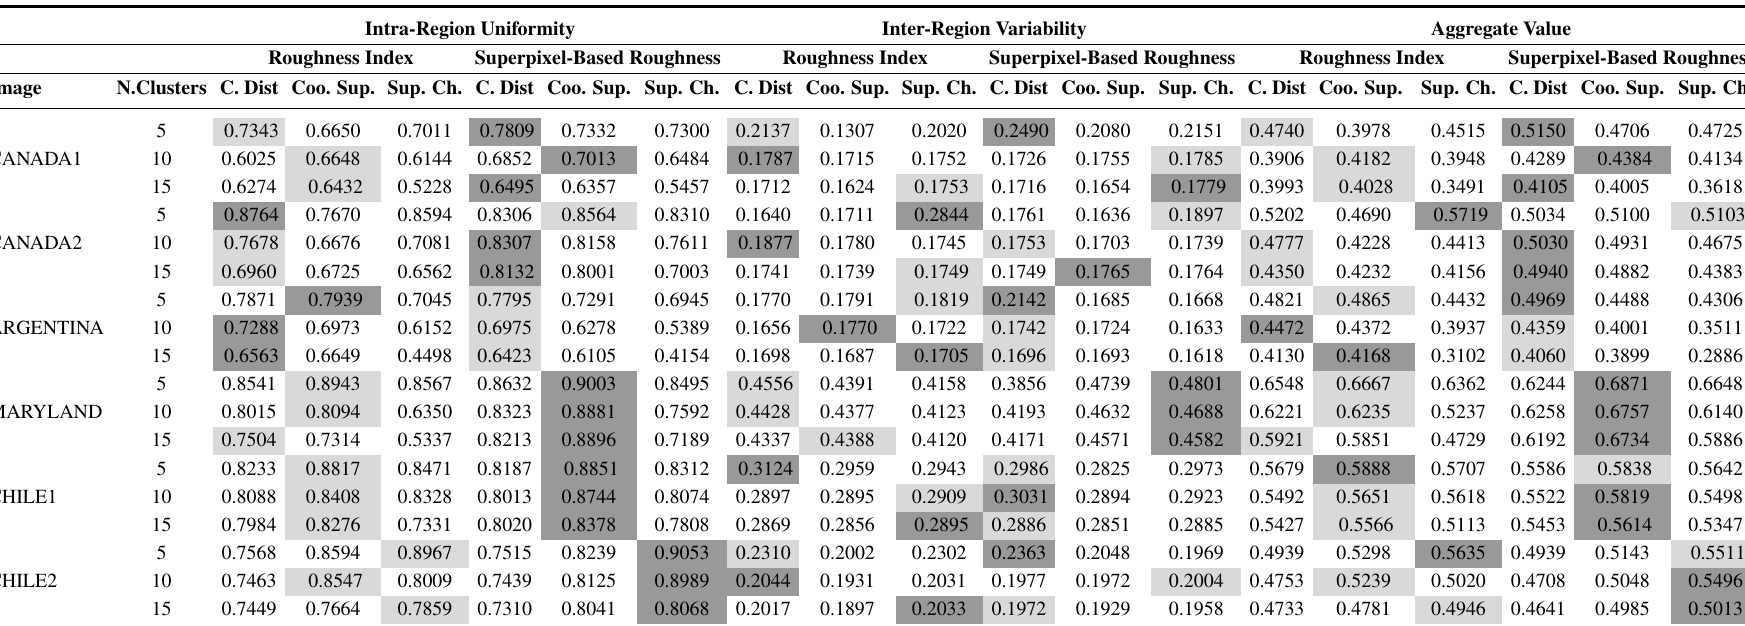
Table 2. Levine and Nazif evaluation criterion results for the original algorithm and the proposed method, ordered by segmentation and merging region methods for 5, 10 and 15 final spectral clusters (where N. Clusters is the number of final spectral clusters, C. Dist is the color distance, Coo. Sup. represents the co-occurrence in the superpixel method and Sup. Ch. is the superpixel characterization method). The best results for each criteria (intra-region uniformity, inter-region variability and the aggregate values) for each segmentation appear highlighted in dark grey. The best results taking into account only the segmentation method are also shown in light